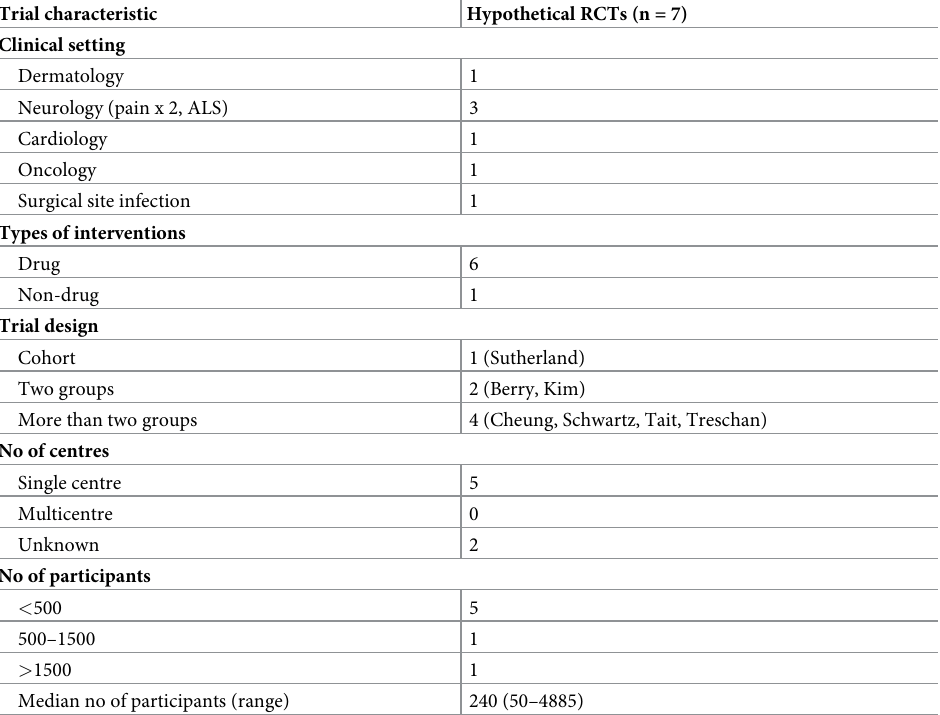
Table 1. Summary characteristics of hypothetical host